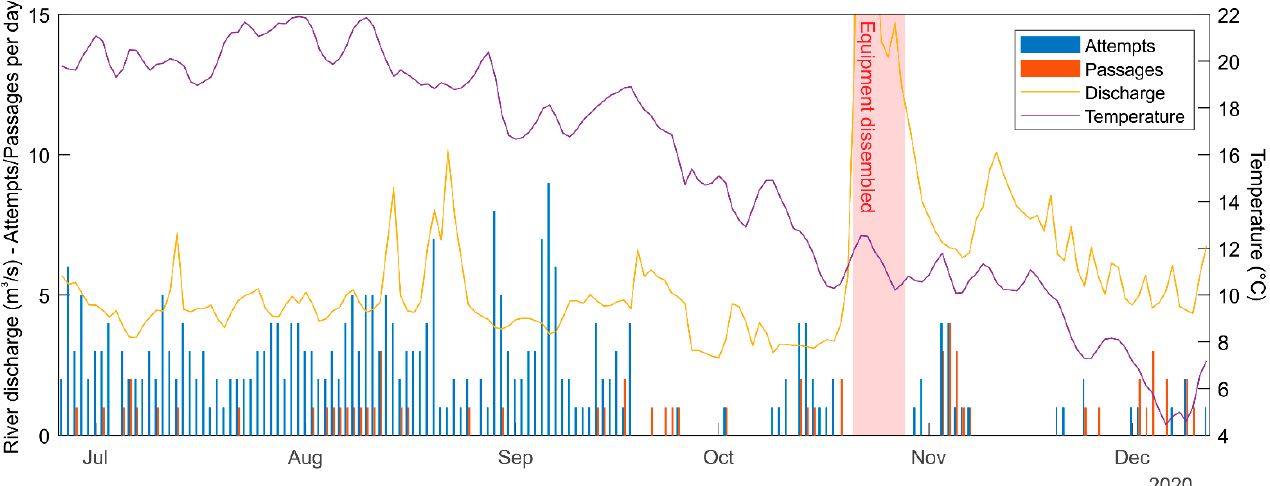
Figure 7. Upstream passage attempts per day and successful passages through the Palencia weir related to the river discharge and water temperature. The time-period with disassembled antennas (due to the damage risk by high flows) has been represented with a shaded area.